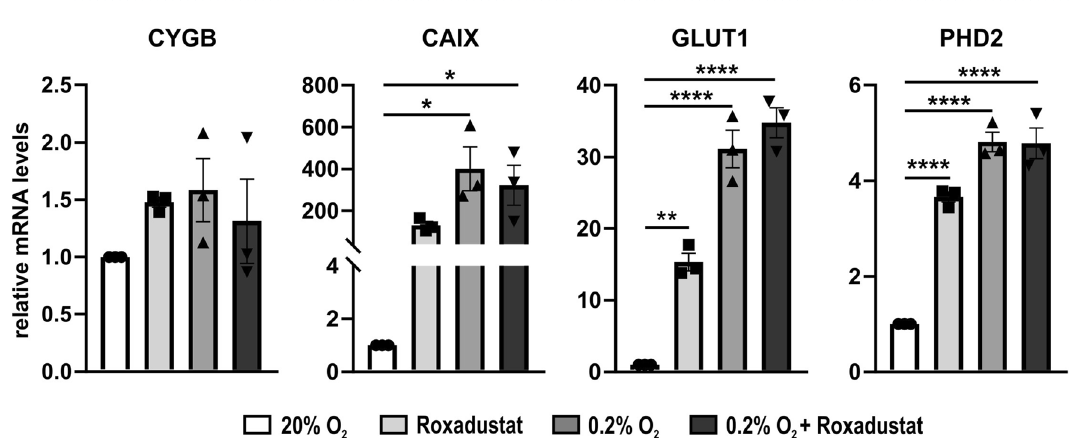
Figure 2. Gene expression after 24 h hypoxia or PHD inhibitor treatment in A375. Average fold change expression of three hypoxia control genes ( CAIX , GLUT1 , and PHD2 ) and CYGB , compared to the normoxic control (set as 1), after 24 h of roxadustat (100 µM), hypoxia (0.2% O 2 ), and combined hypoxia and roxadustat (100 µM). qPCR values were normalized to B2M and YWHAZ (mean ± S.E.M; n = 3). Individual values of replicates are depicted as black dots. One-way ANOVA (* p ≤ 0.05; ** p ≤ 0.01; *** p ≤ 0.001; **** p ≤ 0.0001).